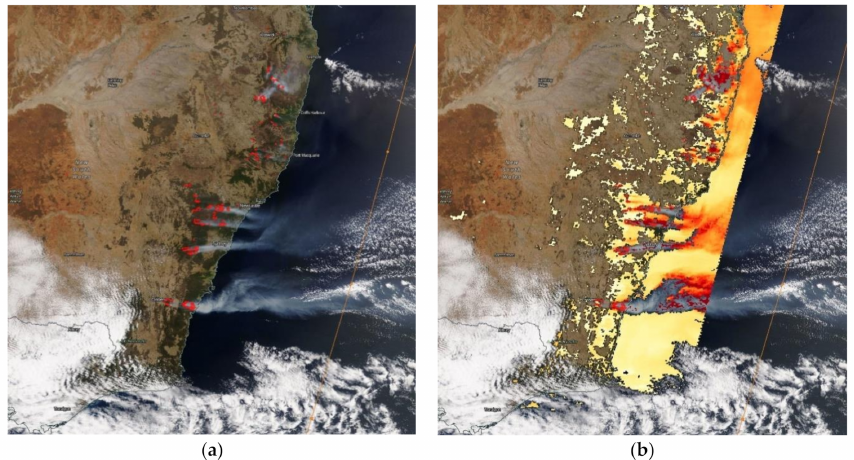
Figure 8. MODIS Terra/Aqua thermal hot spots image on 3 December 2019, 00:00 UTC, ( a ) and the AOD image from the MODIS Terra satellite, land and ocean ( b